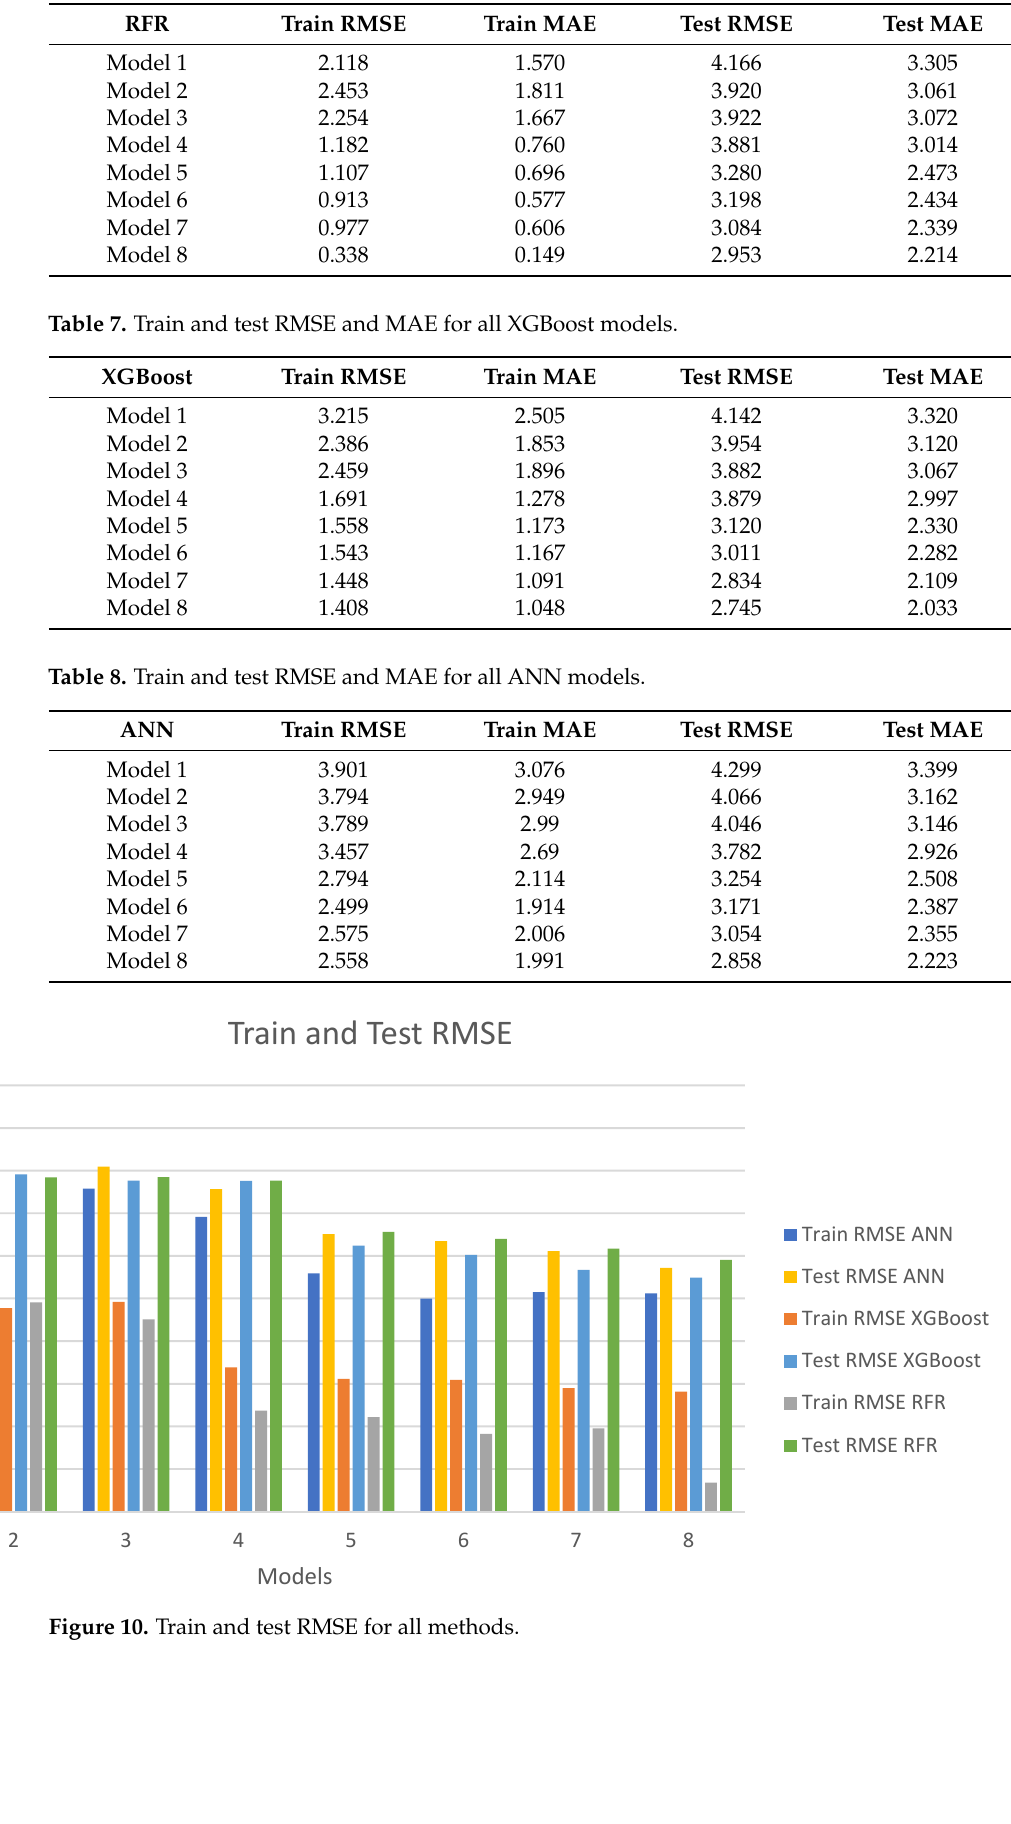
Figure 11. Train and test MAE for all methods.